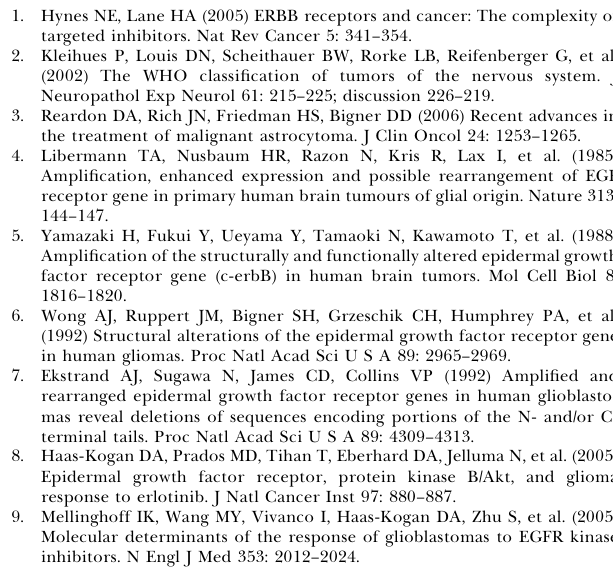
Figure S1. Protein Sequence Alignment for EGFR Missense Mutations Alignment (ClustalW) of the human EGFR protein sequences ERBB2, ERBB3, ERBB4, and the EGFR protein sequence of Mus musculus, Rattus norvegicus, Sus scrofa, Danio rerio, and Drosophila melanogaster and Xiphophorus for the residues affected by missense mutations. Table S1. PCR and Extension Primers for MALDI-TOF Mass Spectrometry Genotyping of 24 SNPs Found at doi:10.1371/journal.pmed.0030485.st001 (18 KB XLS). Table S2. PCR and Extension Primers for EGFR MALDI-TOF Mass Spectrometry Genotyping Found at doi:10.1371/journal.pmed.0030485.st002 (15 KB XLS).